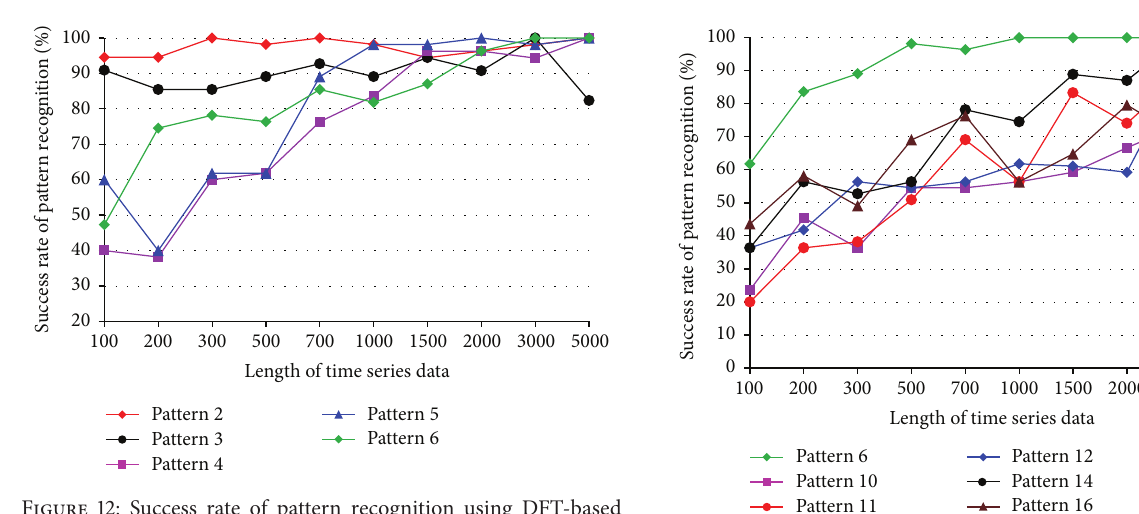
Figure 12: Success rate of pattern recognition using DFT-based feature extraction in first scenario.